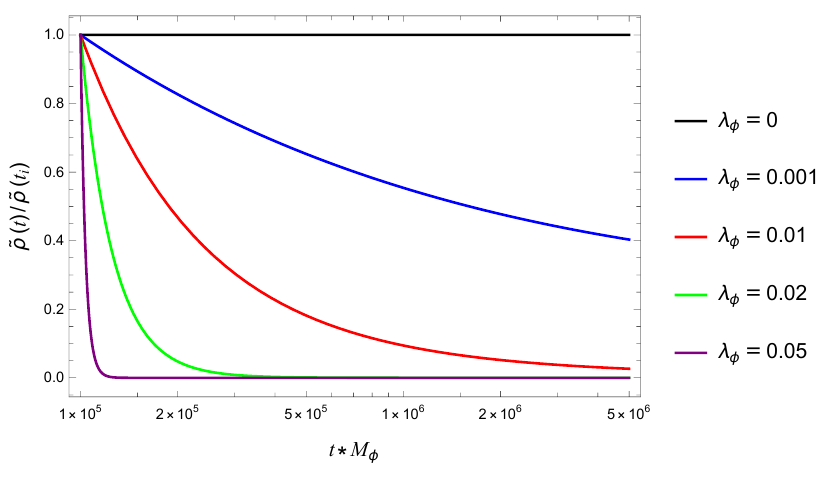
Figure 11 . Evolution of the condensate comoving energy density for the numerical solutions given in figure